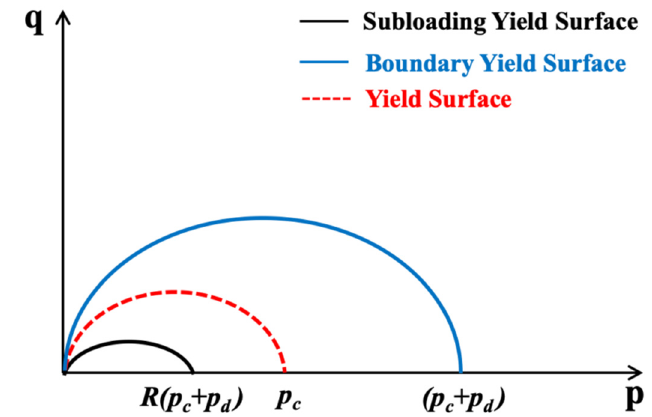
Figure 2. Yield surfaces adopted to model the mechanical behavior of MHBS.